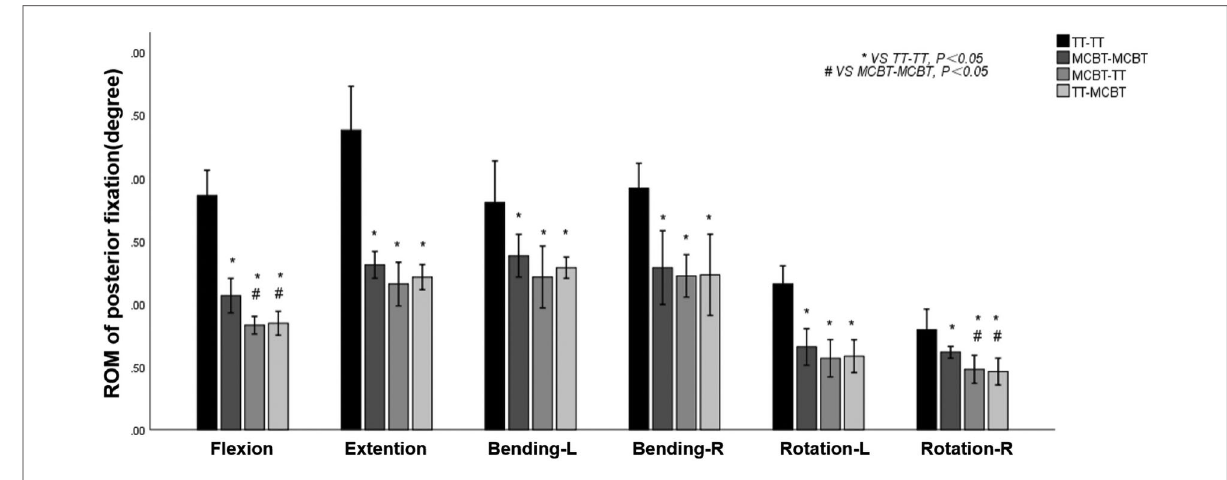
FIGURE 4 Mean values and minimum – maximum ranges of the ROMs of posterior fi xations in four fi xation